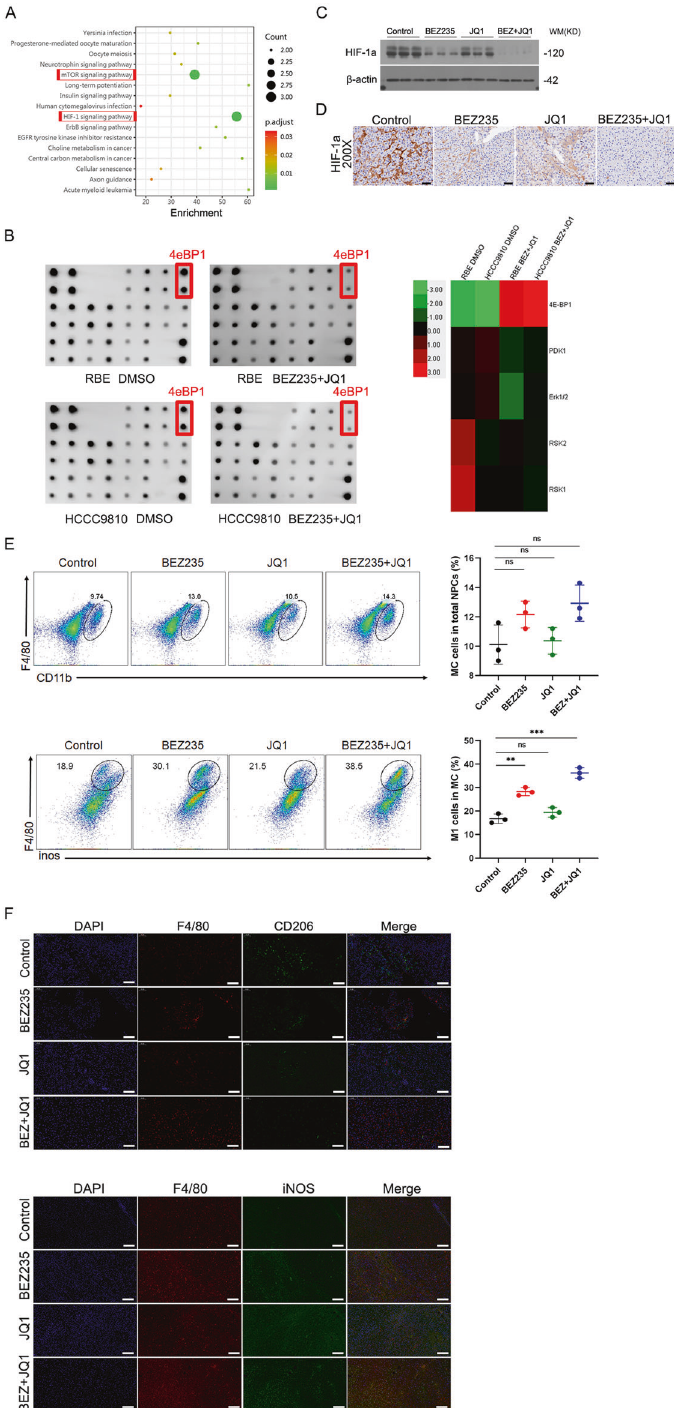
Fig. 7 The effect of combination therapy on the tumor immune microenvironment. A KEGG pathway analysis showing the activated/ phosphorylated protein in RBE cells treated with combination therapy or DMSO for 24hours. B Left: Peptide phosphorylation microarray chips showing phospho-proteins differentially expressed in RBE and HCCC9810 cell lines following DMSO and combination therapy. Right: Heatmap showing phospho-proteins differentially altered in in RBE and HCCC9810 cell lines following DMSO and combination therapy (ANOVA, P < 0.05). Data are median centered (red: greater than the median, green: less). C Western blot analysis and D immunohistochemical staining of HIF-1 α protein levels in ICC tissues derived from four treatment groups (control group, BEZ235 group, JQ1 group, combination group). Magni fi cation, ×200; scale bar, 50 μ m. E Representative fl ow cytometry dot plots and the percentages of MC cells in the total NPC population. F Representative fl ow cytometry dot plots and the percentages of M1 type macrophages in the total macrophages population. The data are shown as the mean ± S.E.M (NS, P ≥ 0.05, ** p <0.01, *** p <0.001). G , H Immuno fl uorescence assay showing the expression of iNOS and CD206 in ICC tissues derived from four treatment groups (control group, BEZ235 group, JQ1 group, combination group). Magni fi cation, ×200; scale bar, 50 μ